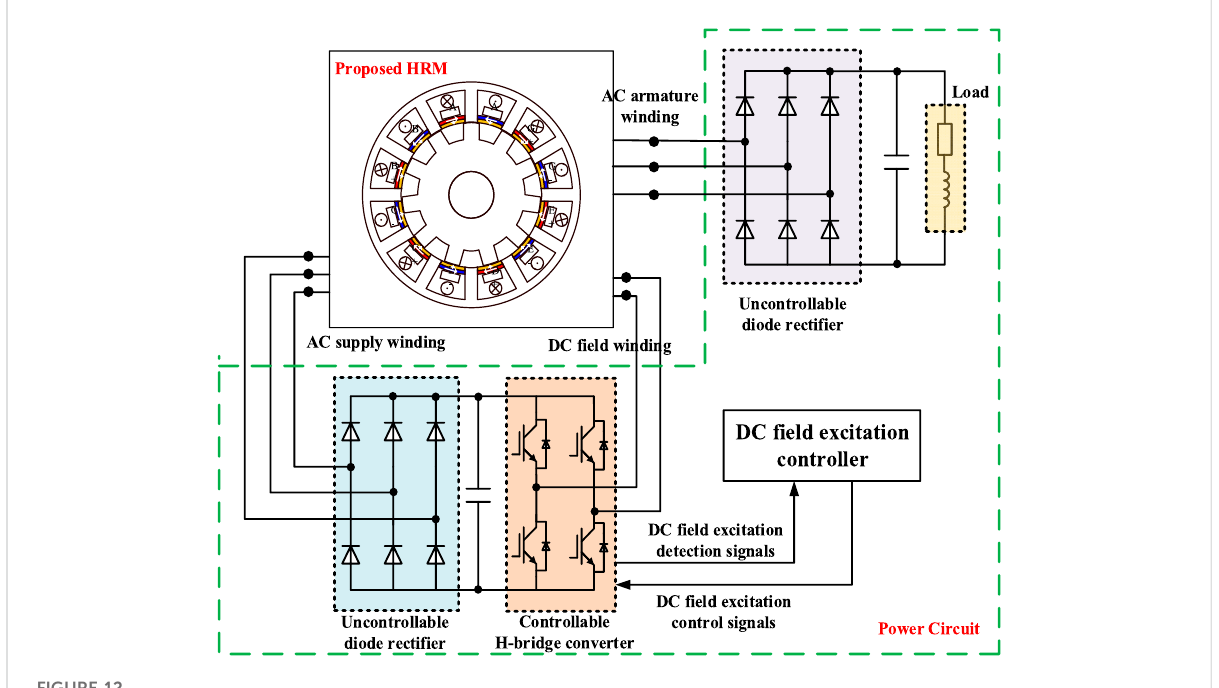
FIGURE 12 Two-stage excitation system for the proposed HRM.